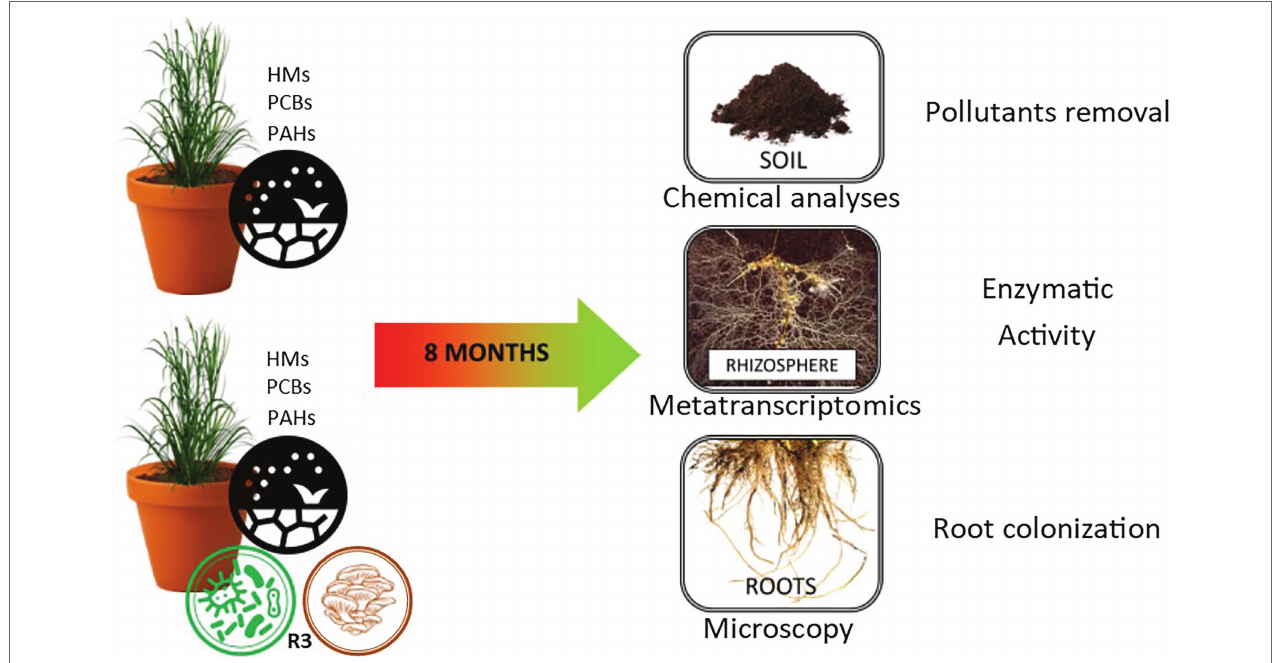
FIGURE 1 | Experimental design.